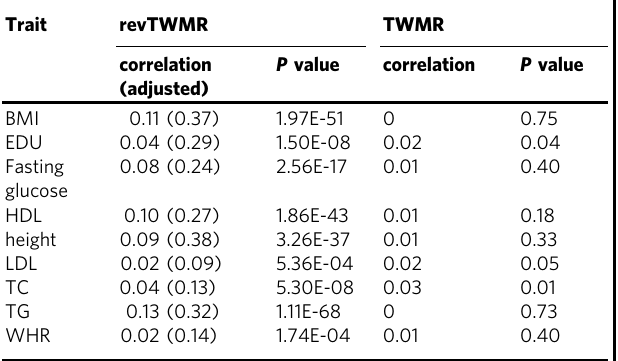
Table 1 Correlation between observational phenotype-gene expression correlation and revTWMR and TWMR effects.